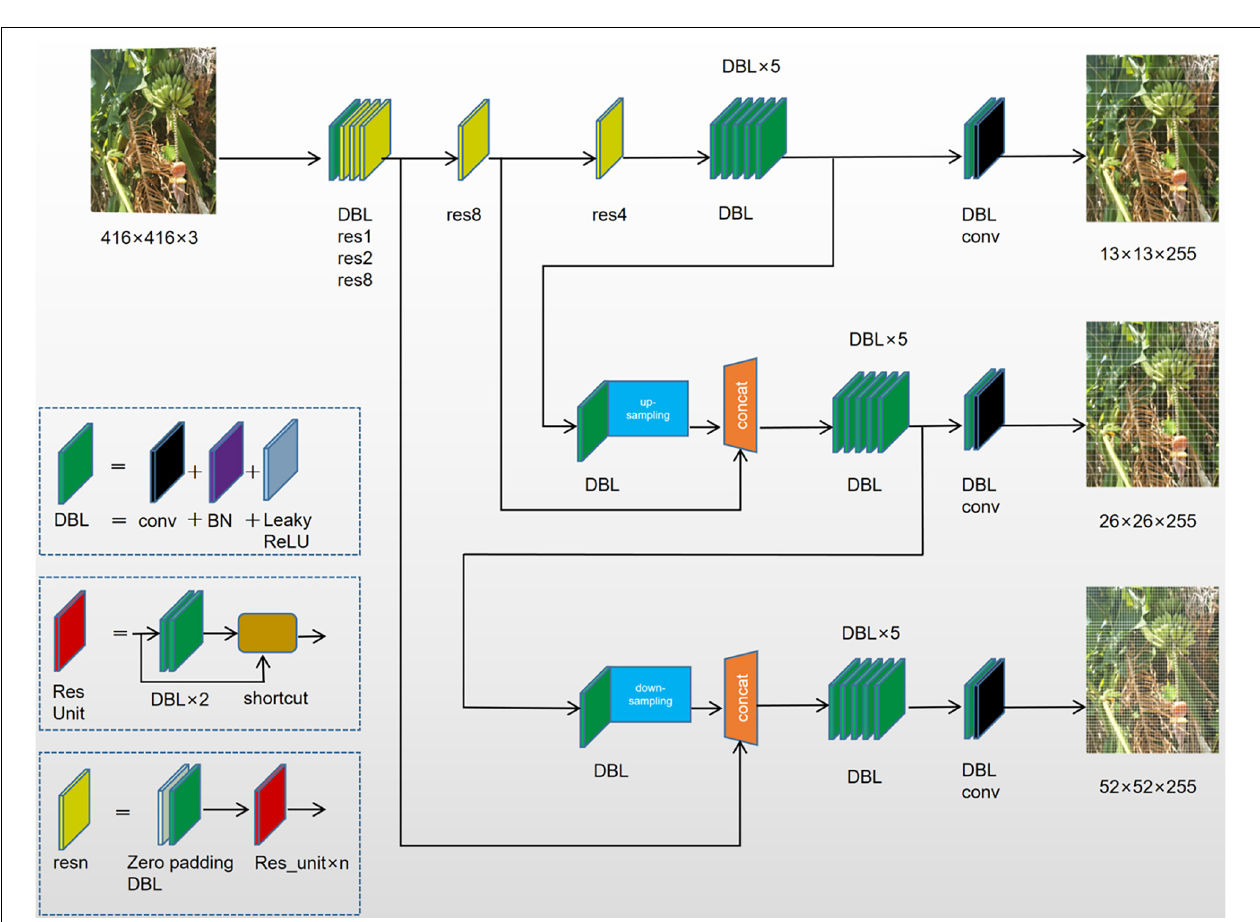
FIGURE 4 | YOLOv3 network architecture for the multi-feature targets of banana plants.